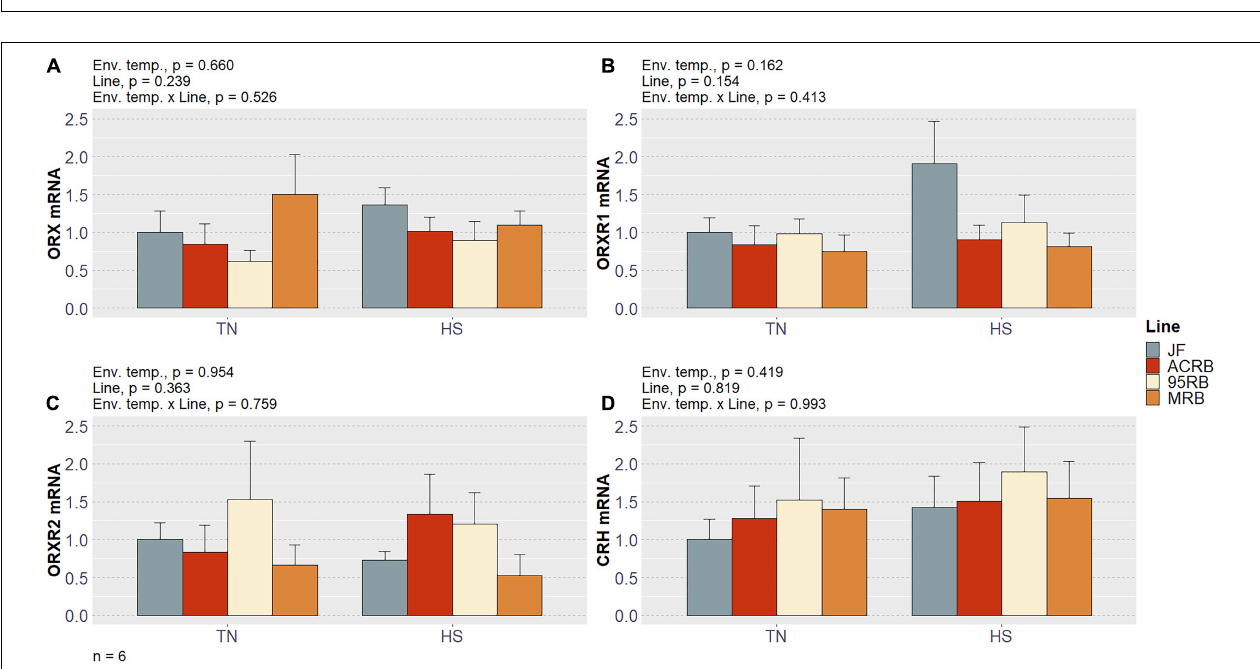
FIGURE 2 | Effect of cyclic heat stress on the hypothalamic expression of the melanocortin receptor system in JF and modern broilers. The expression of MC1R (A) , MC2R (B) , MC3R (C) , MC4R (D) , and MC5R gene (E) was determined by qPCR using 2 − (cid:49)(cid:49) Ct method. JF-TN group was used as a calibrator. Data are mean ± SEM ( n = 6 birds/group). HS, heat stress; TN, thermoneutral.